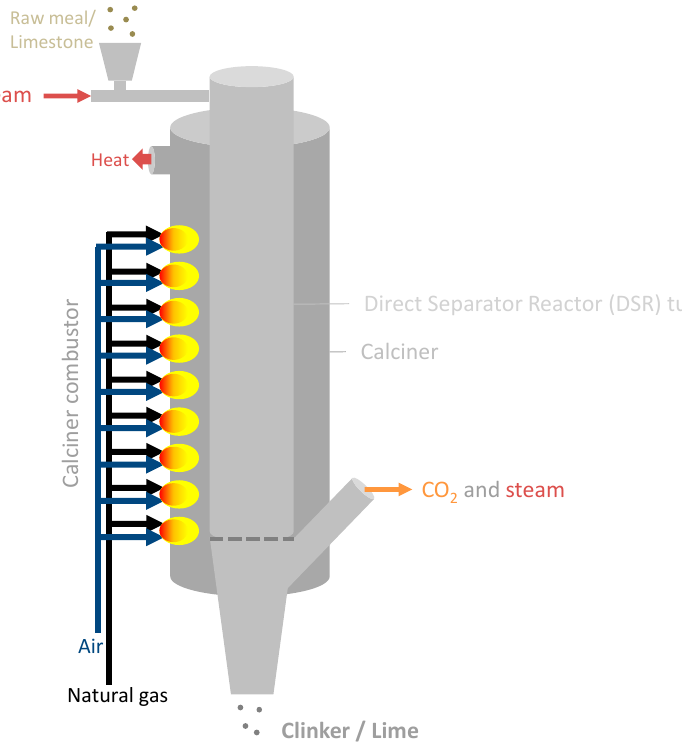
Figure 15. Scheme of LEILAC’s direct separator reactor (adapted from [81]).